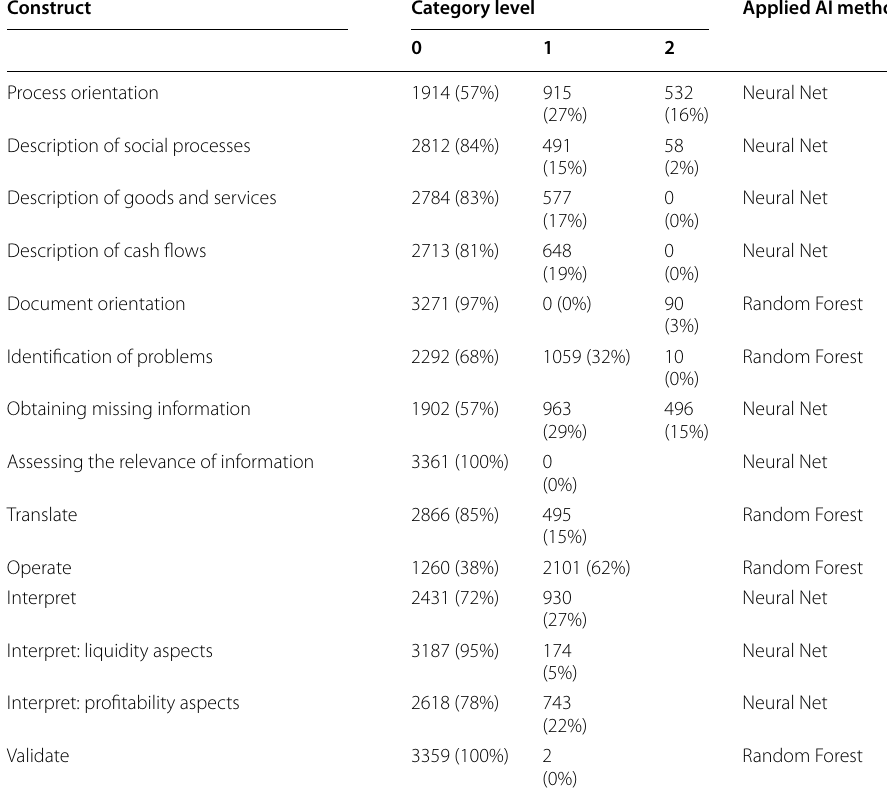
Table 4 Relative and Absolute Frequencies of the Category Levels Generated by AI